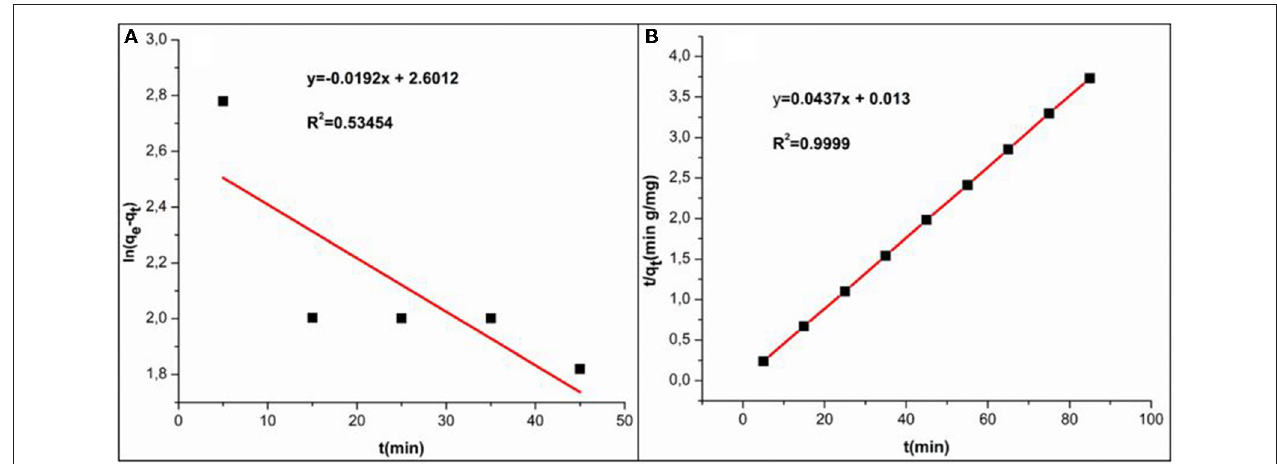
FIGURE 7 | (A) Linear Pseudo-first-order; (B) Pseudo-second-order model for Cr(VI) adsorption by Fe 3 O 4 /FMO.